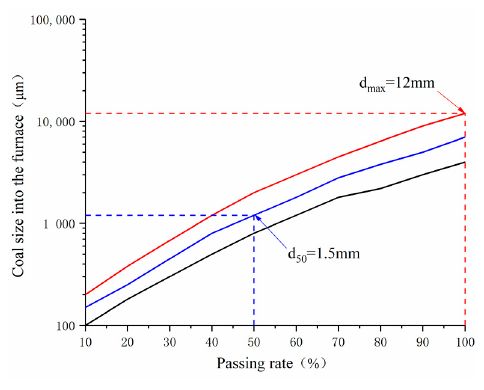
Figure 3. Coal size distribution range.